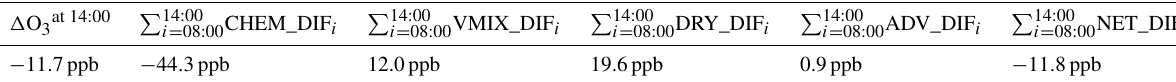
Table 3. The reduction in surface ozone at 14:00LT and the corresponding accumulated changes in process contributions.